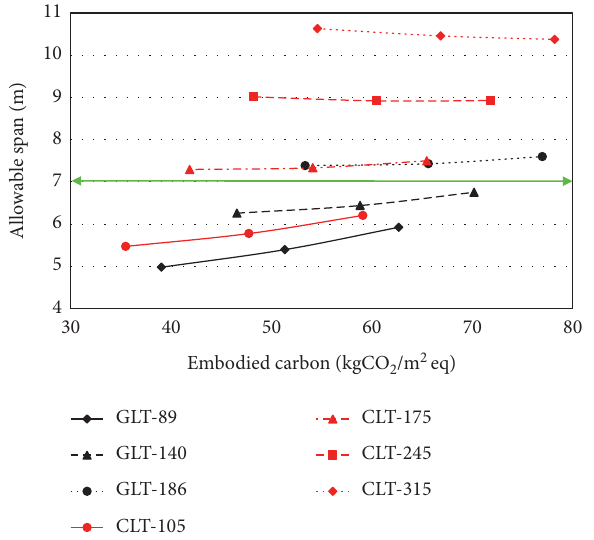
Figure 7: Allowable span versus embodied carbon of TCC system (the three points on each curve represent from left to right 50mm, 75mm, and 100mm thick